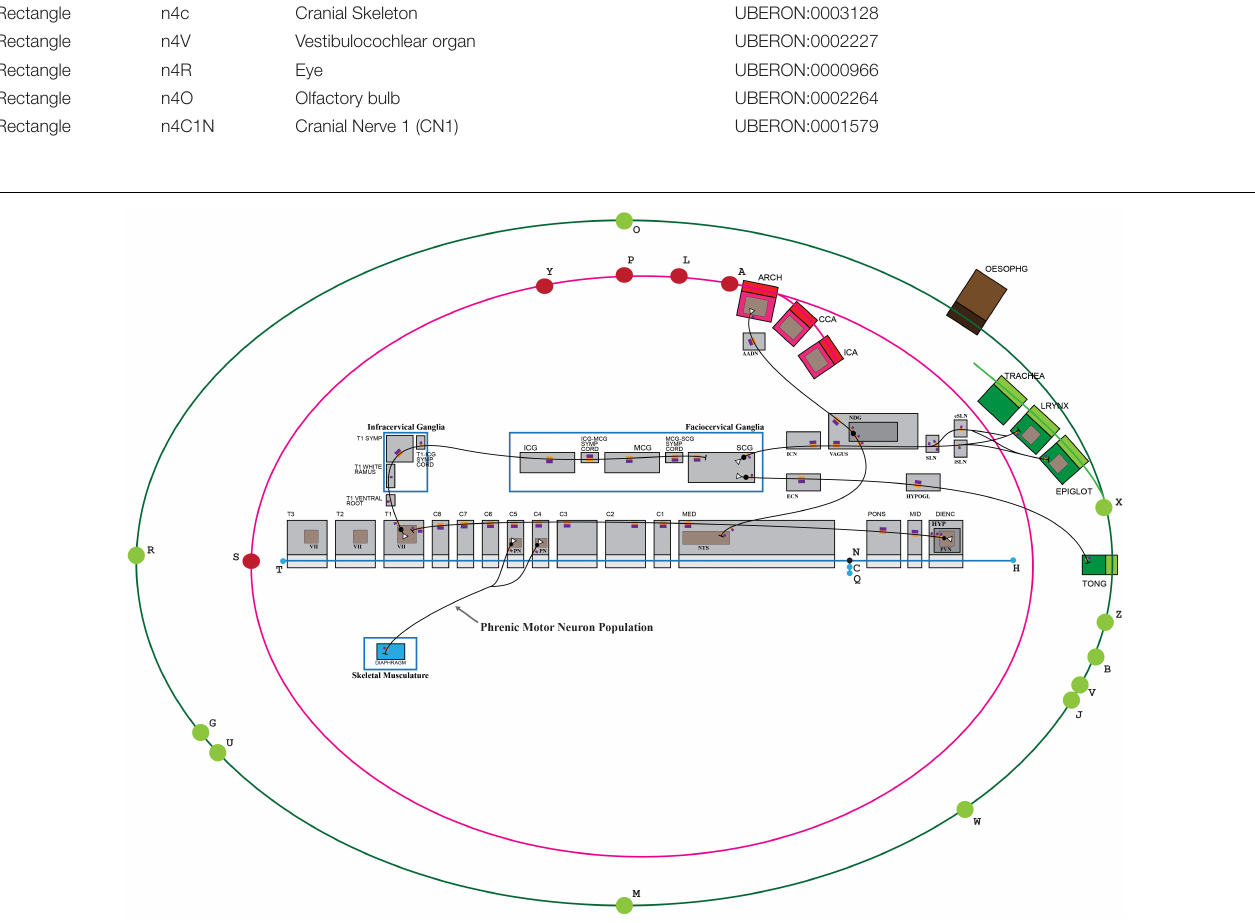
FIGURE 5 | TOO map providing a visual context to an ApiNATOMY connectivity model. Some elements of the TOO map that are not required to anchor the connectivity model have been concealed for ease of viewing. The blue edge defined by nodes (H,T), representing the flow of CSF, serves to organize conduits representing contiguous structures in the Central Nervous System. KEY: Black lines represent the flow of neuronal cytosol; Black circles represent neuronal somata; Open white triangles represent the dendritic terminus of a neuron; Purple-and-orange rectangles represent segments on neurons (orange: innermost, cytosolic layer; purple: plasma membrane); T1: first thoracic; T1 SYMP: sympathetic ganglion at the level of T1; ICG: inferior cervical ganglion; MCG: middle cervical ganglion; SCG: superior cervical ganglion; ICN: internal carotid nerve; ECN: external carotid nerve; HYPOGL: hypoglossal nerve; NDG: nodose ganglion; SLN: superior laryngeal nerve; iSLN: internal SLN; eSLN: external SLN; LRYNX: larynx; EPIGLOT: epiglottis; TONG: tongue; OESOPHG: esophagus; NTS: nucleus tractus solitarius; ARCH: arch of the aorta; CCA: common carotid artery; ICA: internal carotid artery; AADN: aortic arch depressor nerve.